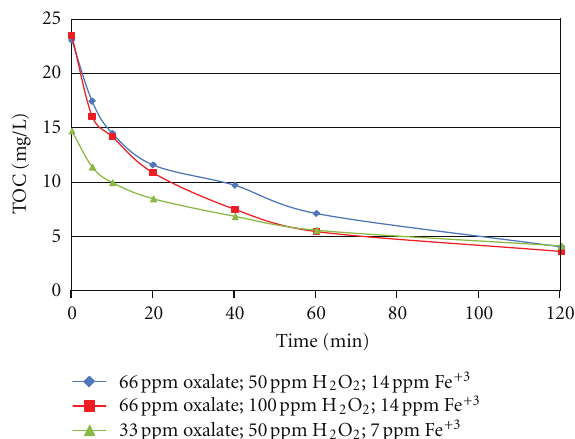
Figure 10: Homogeneous photocatalysis of mepiquat chloride using the ferrioxalate agent (initial conditions: 10ppm mepiquat chloride, 0.5g/L TiO 2 P-25, UV-A lamp).